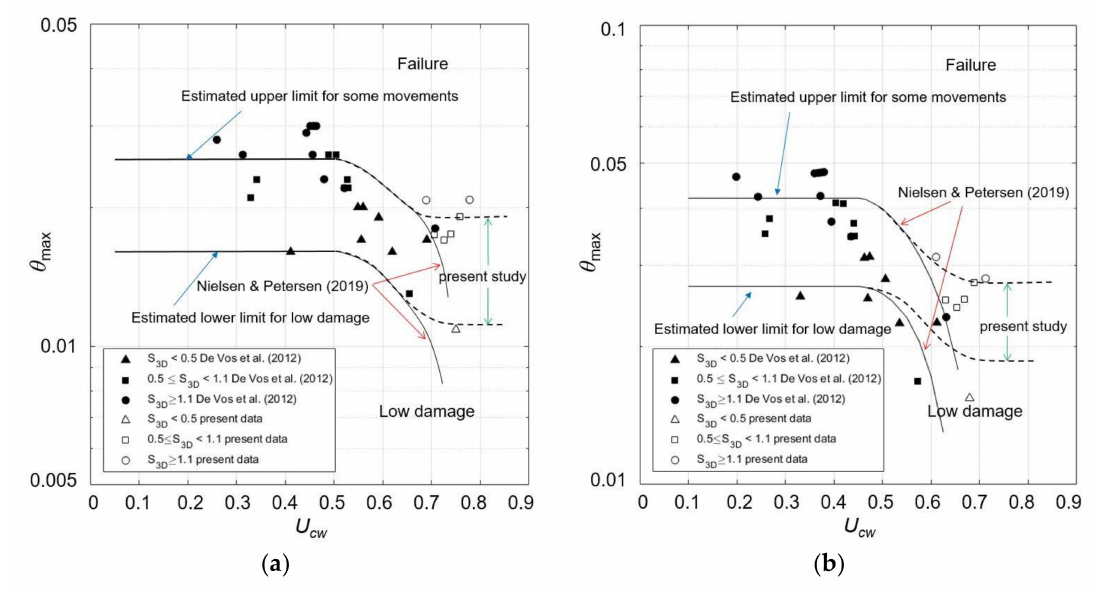
Figure 13. Limit lines for failure judgement using θ max for di ff erent U cw conditions: ( a ) θ max is calculated using U m ; ( b ) θ max is calculated using U s , U s = 2 U rms